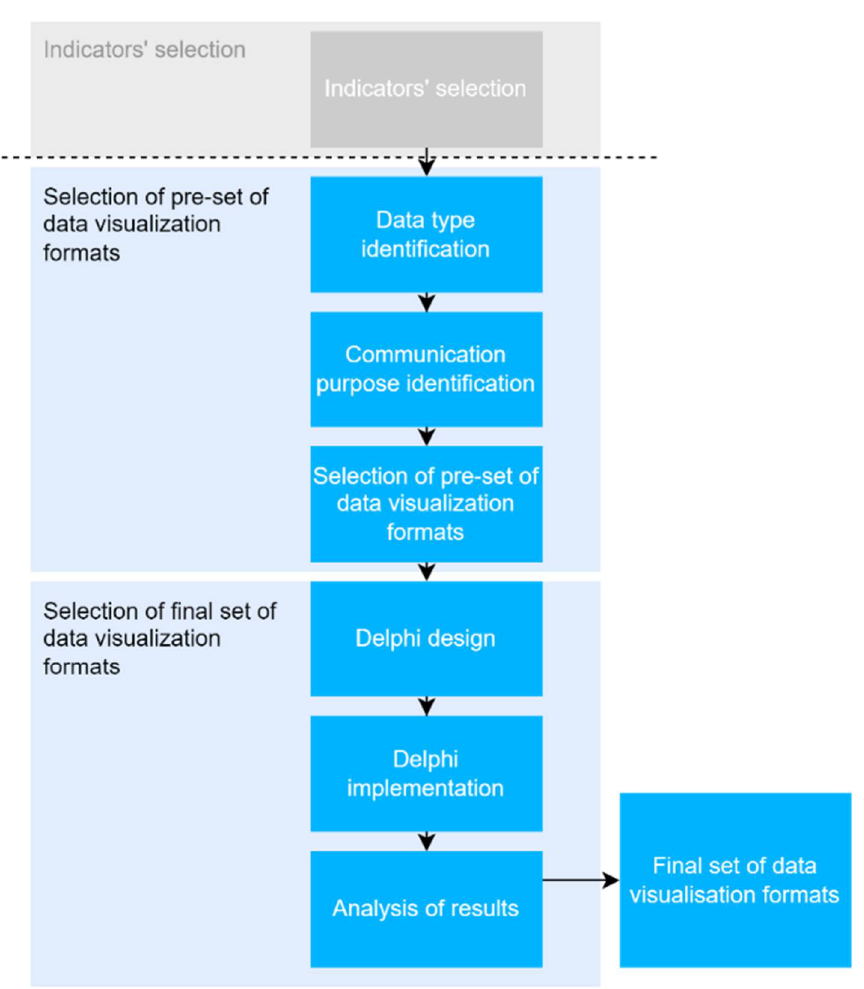
Figure 1. Steps performed for the implementation of the proposed approach.